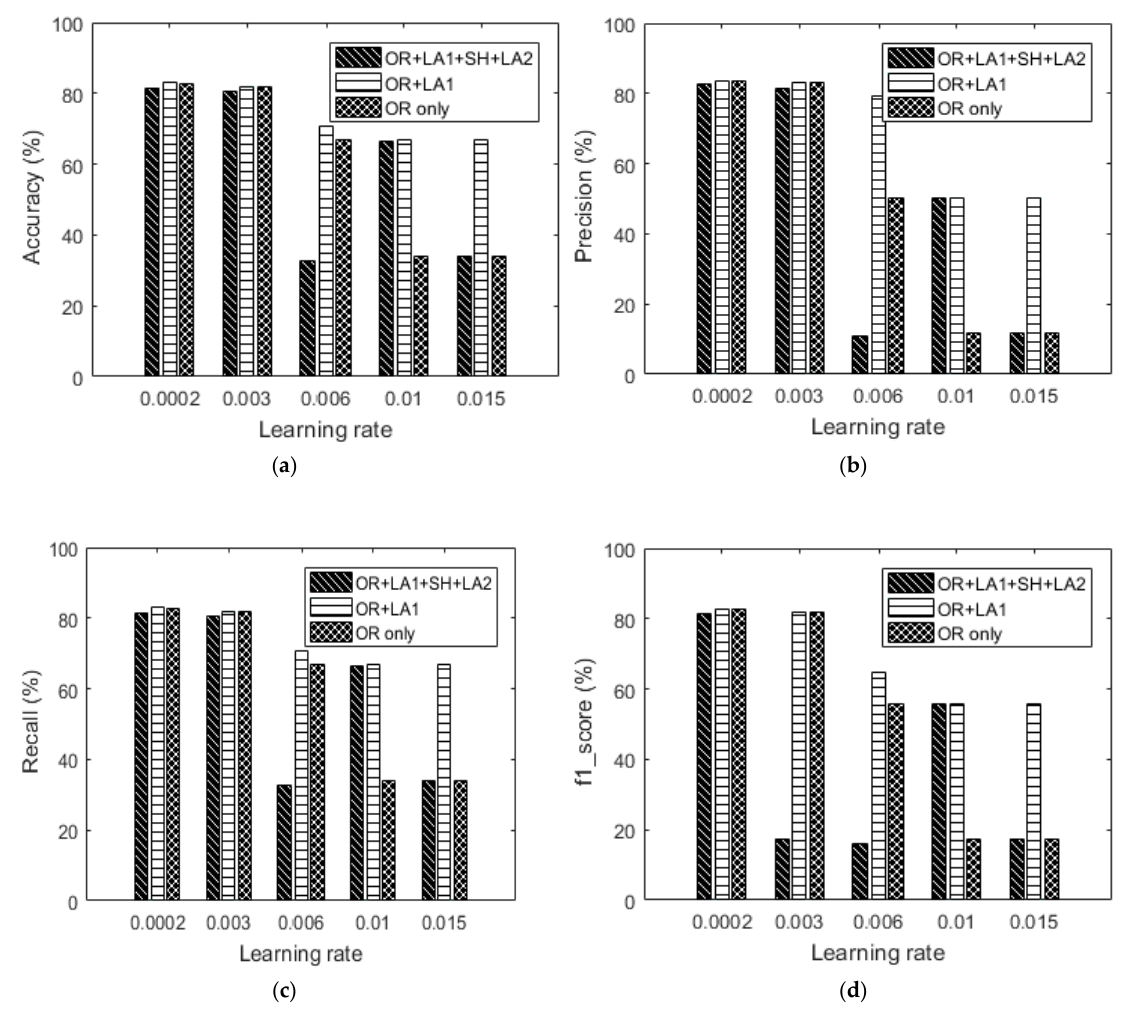
Figure 15. 100-feature vector dataset: ( a ) Accuracy versus learning rate, ( b ) precision versus learning rate, ( c ) recall versus learning rate and ( d ) f1_score versus learning rate. Table 9. Confusion matrices: (OR + LA1)—200-feature vector dataset.